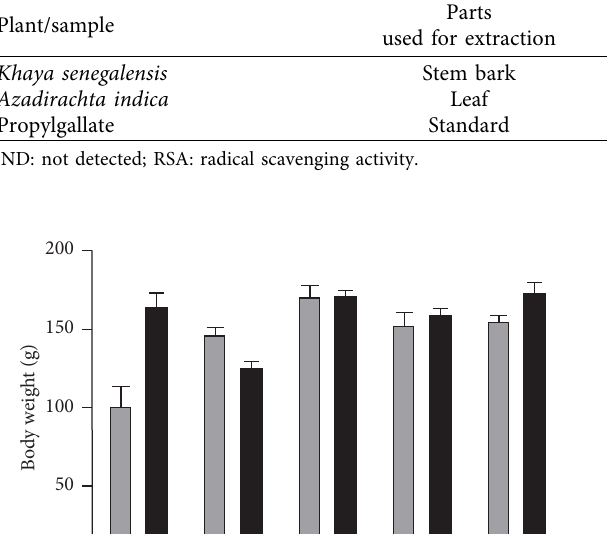
Table 1: DPPH free radical scavenging property results of 80% hydroethanolic extracts of K. senegalensis stem bark and A. indica leaves. Plant/sample